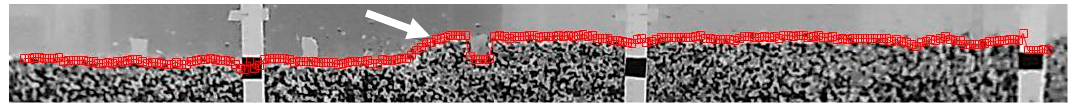
Figure 13. Detected bed profile, with the arrow indicating the bed elevation determined from the vertical profile of Figure 13.